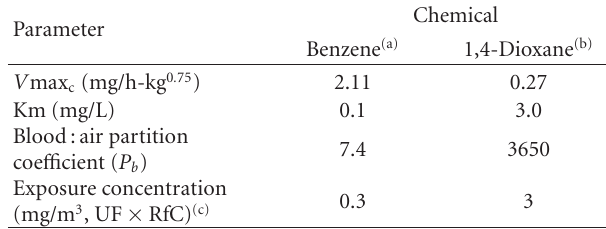
Table 1: Chemical-specific parameters used in the steady-state